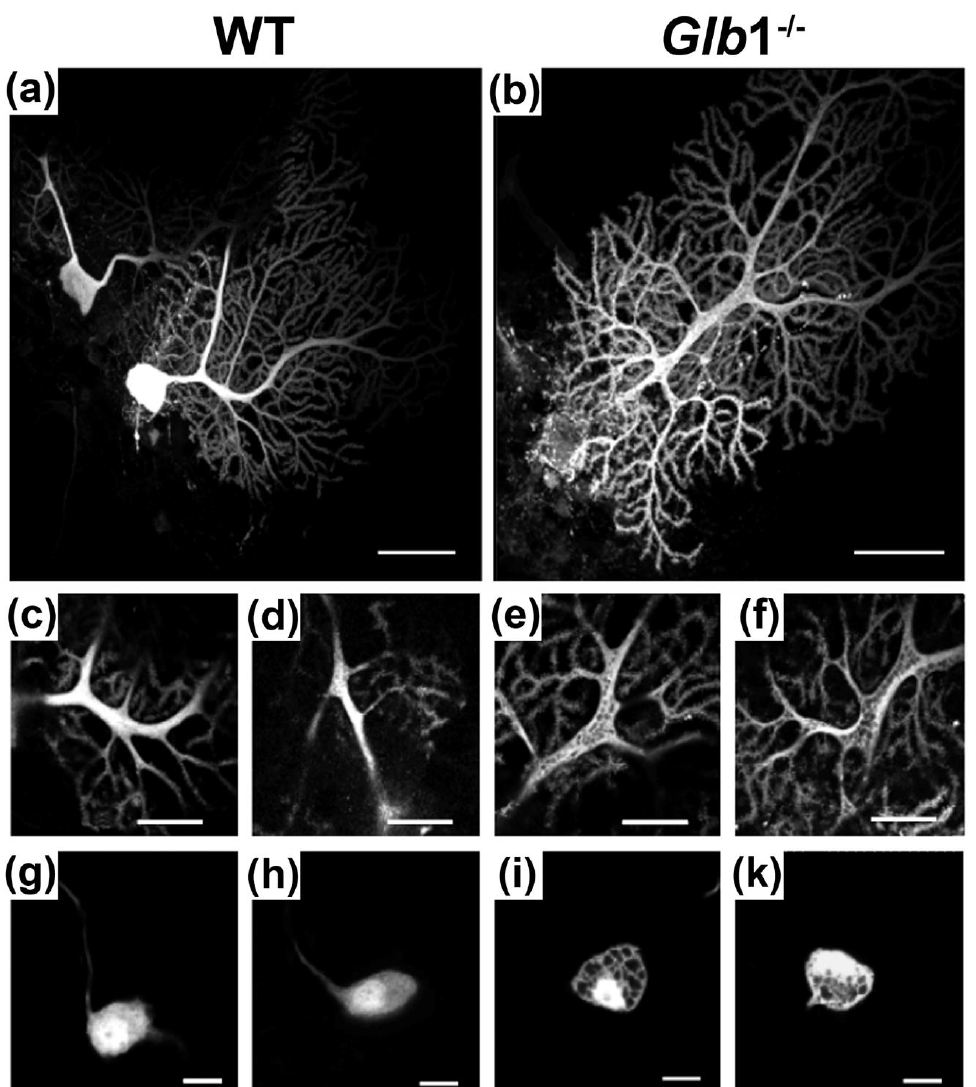
Figure 6. Electroporation: Single cell stainings of 3.5 to five-month-old Glb1 -/- and wildtype (WT) neurons. ( a ) Purkinje cell of a WT mouse; ( b ) Purkinje cell of a Glb1 -/- mouse; ( c , d ) single optical sections of Purkinje cell dendrites of the WT animal; ( e , f ) single optical sections of Purkinje cell dendrites of the Glb1 -/- animal; ( g , h ) dendrites of principal cells of the medial nucleus of the trapezoid body of the WT; ( i , k ) vacuolation of dendrites of principal cells of the medial nucleus of the trapezoid body of the Glb1 -/- mouse. Bars: ( a , b ): 60 µm, ( c – f ): 20 µm, ( g – i , k ): 10 µm.